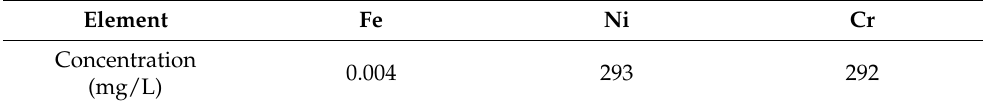
Table 5. The metal concentrations of the